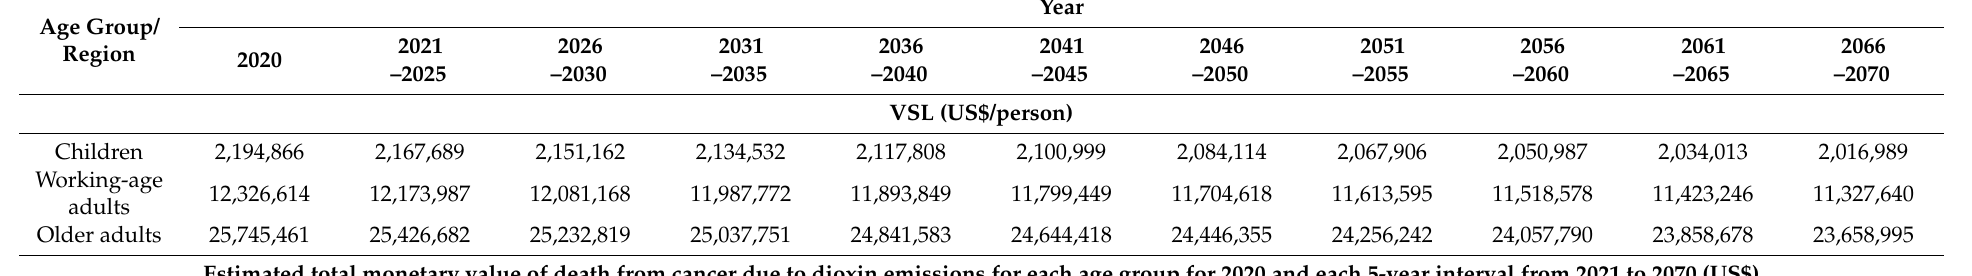
Table 6. Estimated VSLs for the different population age groups in 2020 and the projected population age groups every 5 years from 2021 to